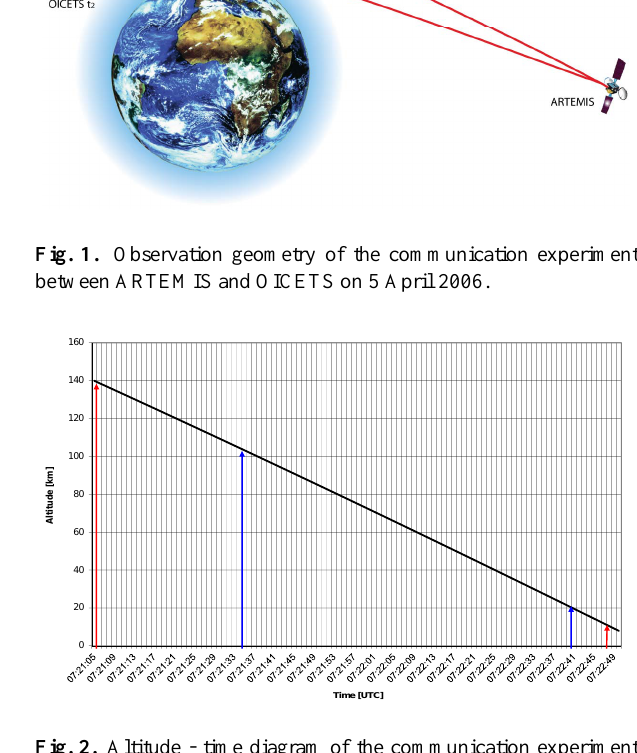
Fig. 2. Altitude - time diagram of the communication experiment between ARTEMIS and OICETS on 5 April 2006. Start and end of data records are marked in blue for ARTEMIS and red for